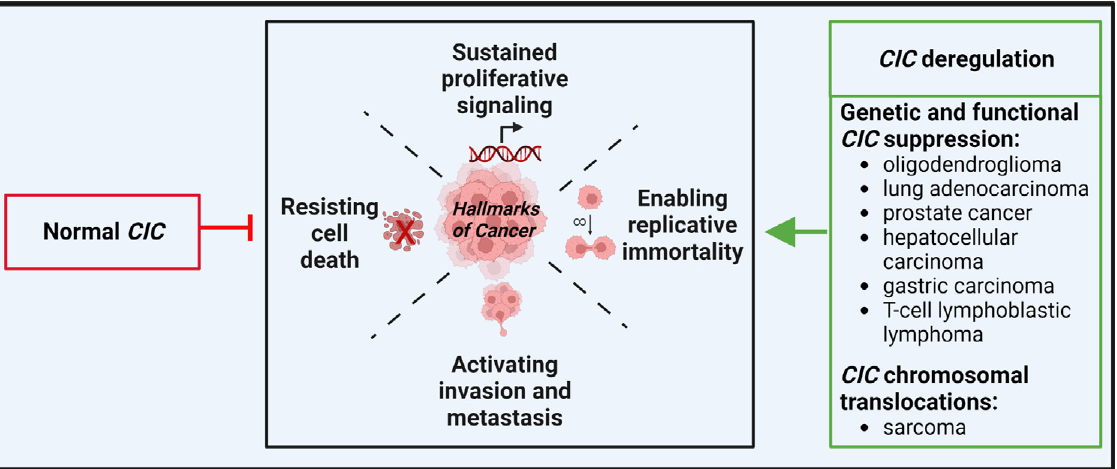
Figure 2. Schematic representation of CIC significance in cancer. Normal CIC acts as an oncosup- pressor by inhibiting cancer onset and progression through repression of gene transcription. On the contrary, CIC deregulation promotes the reported hallmark features of cancer. Depending on the tumor type, as listed, CIC is: 1. suppressed or inactivated, following its genetic or functional alteration; or 2. transformed into a chimeric aberrant transcriptional activator by chromosomal translocation.